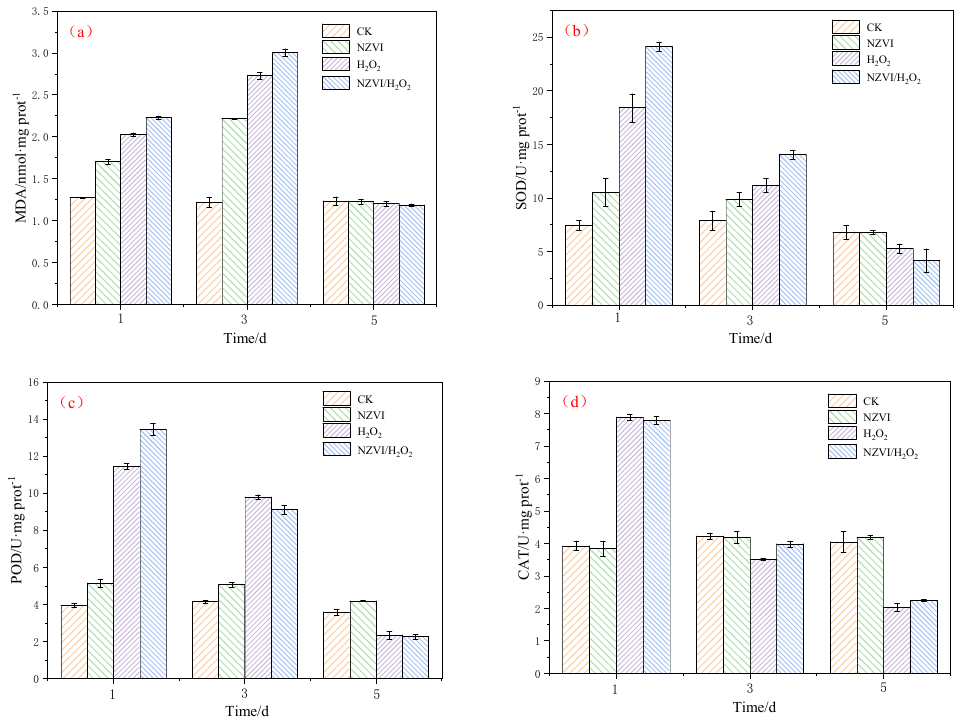
Figure 3. The variation of antioxidant enzyme activities in single and combined experiments for ( a ) MDA content; ( b ) SOD activity; ( c ) POD activity; and ( d ) CAT activity. Mean ± standard deviation of three replicates is shown for each